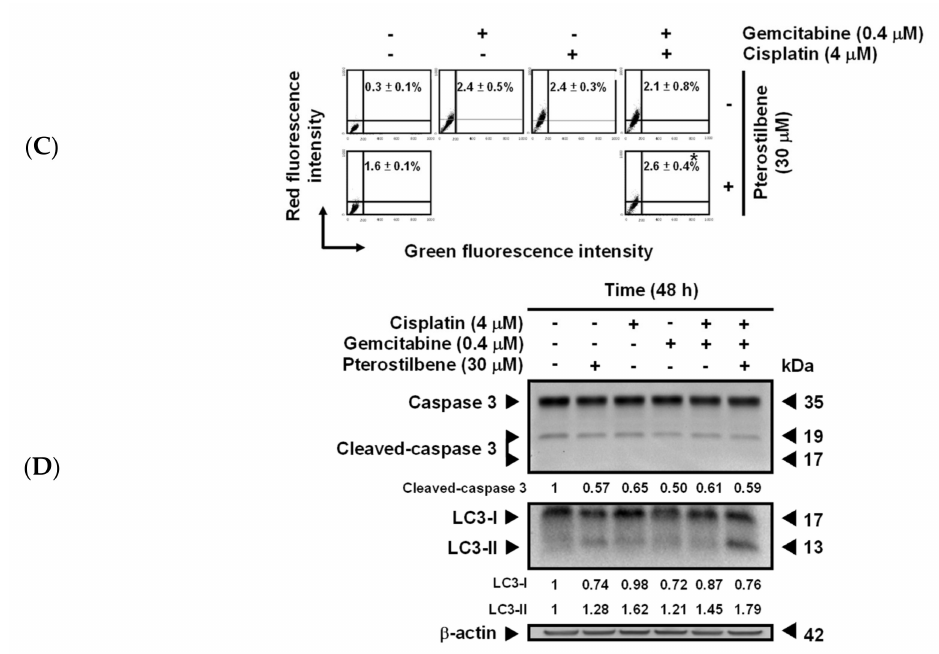
Figure 3. E ff ects of pterostilbene on biosensitivity, apoptosis, and autophagy of T24 cells treated with cisplatin and gemcitabine. ( A ) Pterostilbene enhanced the biosensitivity of T24 cells to a combination of cisplatin and gemcitabine. T24 and E7 cells were treated with the indicated concentration of compounds for 48 h. Cytotoxicity of the cells was determined using 3-[4,5-Dimethylthiazol-2-yl]-2,5- diphenyltetrazolium bromide (MTT) assay. Data of at least three independent experiments were quantified and are presented as means ± standard errors of the means (SEMs). Means in each plot and each cell line with di ff erent superscript letters are significantly di ff erent, p < 0.05. ( B ) Pterostilbene enhanced the autophagy of T24 cells treated with anticancer drugs. ( C ) Pterostilbene did not induce autophagy of E7 cells. After treatment for 48 h, the T24 and E7 cells were stained with acridine orange before flow cytometry. The percentages in the figure indicate the proportion of cells (upper two quadrants) with AVOs staining of at least three independent experiments. Data are presented as means ± SEMs. * denotes a significant di ff erence compared to the group in the absence of pterostilbene, p < 0.05. ( D ) Protein expression of cleaved caspase 3 and LC3-II. After treatment for 48 h, the total protein of T24 cells was subjected to Western blot analysis. Anticaspase 3 and anti-LC3 antibodies served as probes. β -actin served as a loading control. The intensity of each protein expression band was quantified through densitometry normalization to that of β -actin, with the control level arbitrarily set to 1. Results are representative of three independent